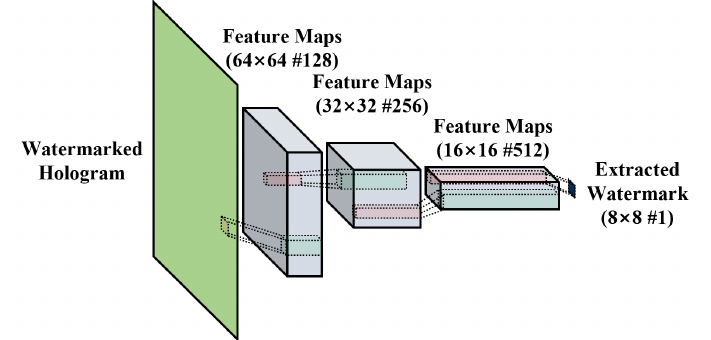
Figure 4. Network structure of the watermark-extracting network